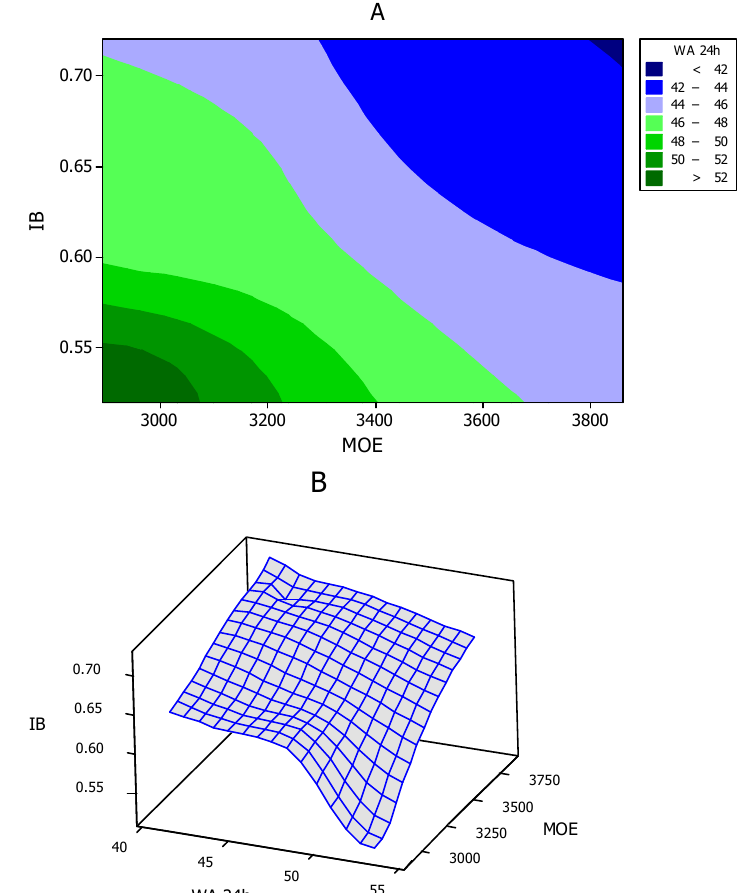
Figure 7. Contour ( A ) and surface ( B ) plots in the six different HDF panels produced. REF 4: 4% UF resin; HDF Type 1: 4% UF resin and 4% ALS; HDF Type 2: 4% UF resin and 6% ALS; HDF Type 3: 4% UF resin and 8% ALS; and REF 6: 6% UF resin. (IB = internal bond; MOE = modulus of elasticity; WA 24 h = water absorption after 24 h of immersion in water).